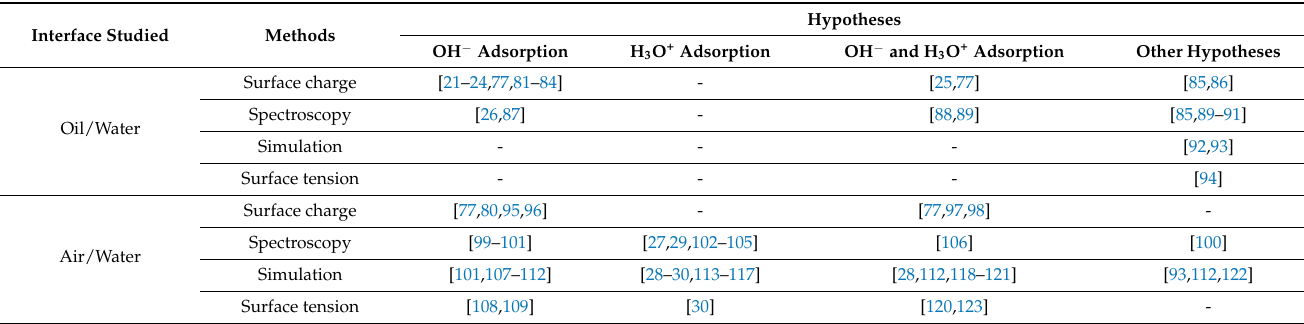
Table 3. Interfacial organization hypotheses defined from different experimental methods and interfaces